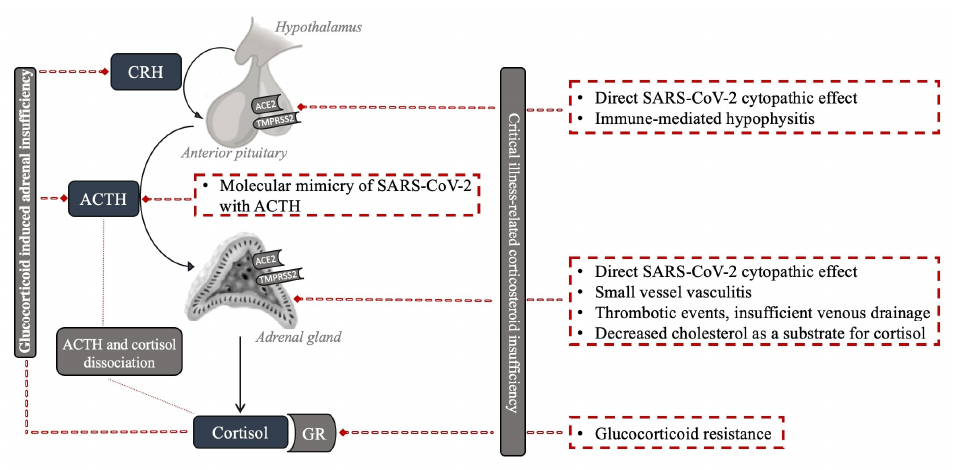
Figure 1. Potential mechanisms of HPA axis impairment with SARS-CoV-2 infection.